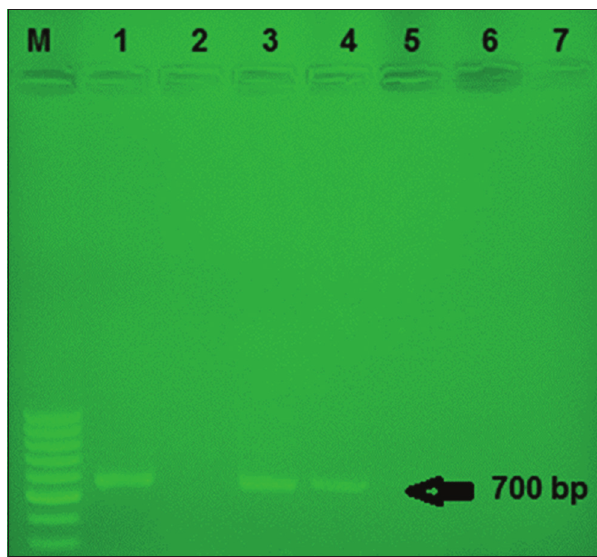
Figure-1: Agarose gel electrophoresis of polymerase chain reaction products using specific primers and DNA from different Paenibacillus larvae subsp . larvae isolate as a template. M: 1 kb marker, 1: Positive control, 2: Negative control, 3-4: Positive samples, 5-7: Negative